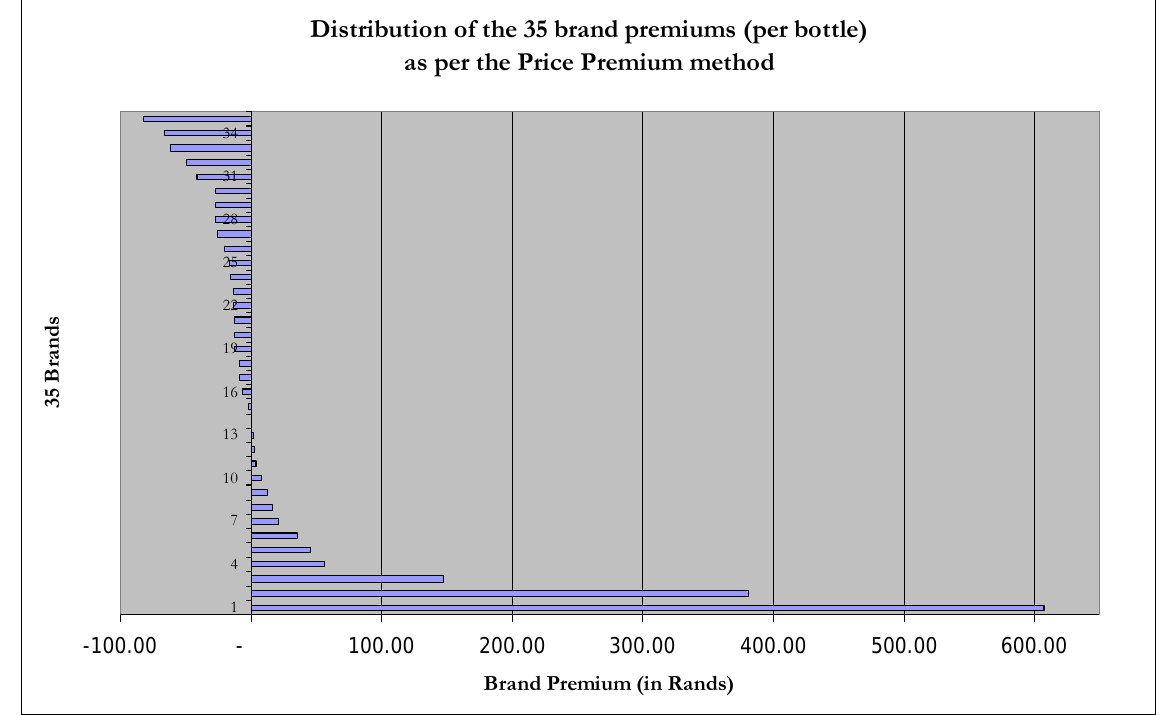
Figure 4: Brand premium distributions for the price premium brand equity estimate. This estimate of brand equity is defined as the difference between bottle price and a valuation of the bottle’s intrinsic worth when tasted blind. This in effect, is the error term derived from the blind-based pricing model ( ε ), and explains why these valuations are so much more blind volatile than the ( ε - ε ) resolution of the quality premium method. (Figures in 2007 blind sighted